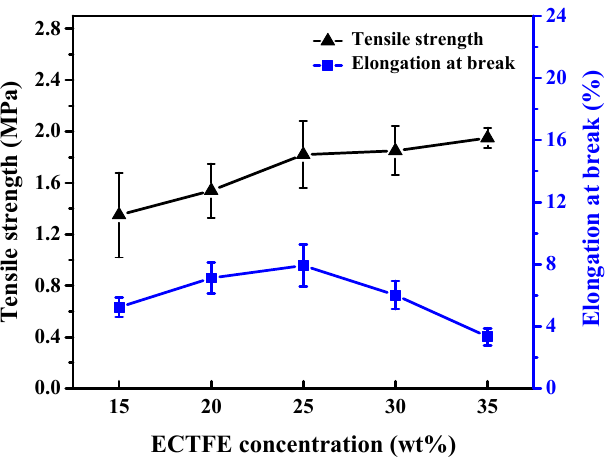
Figure 5. Mechanical strength of the ECTFE porous membrane prepared with different polymer